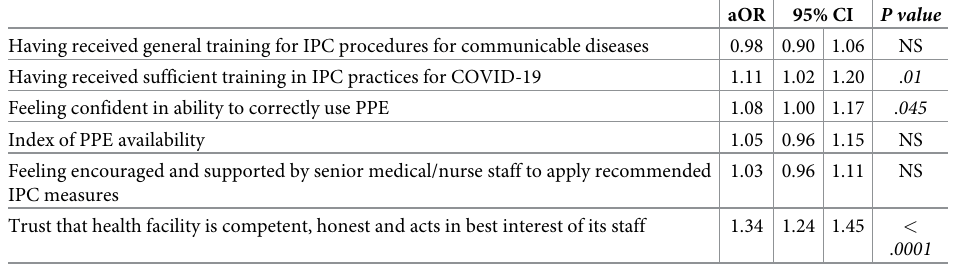
Table 3. Ordered logistic regression for the effect of perceived skills, self-reported environmental context, social influences and institutional trust on a positive sense of control over getting infected with COVID-19 a .